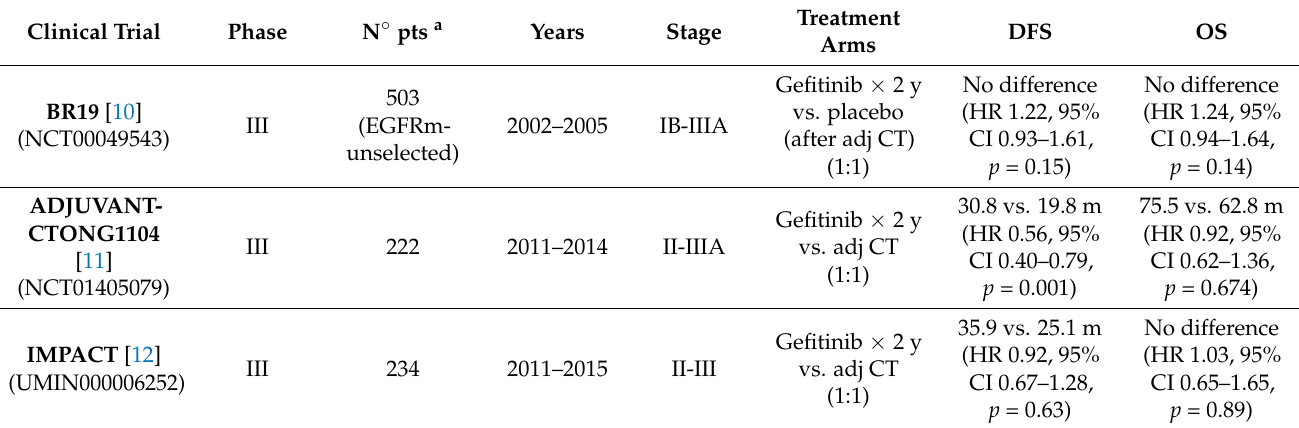
Table 1. Clinical trials with available data with EGFR-TKIs in the adjuvant setting. Clinical